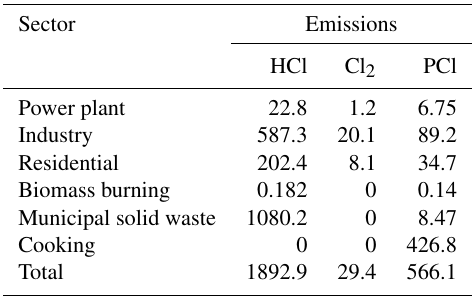
Table 1. The sectoral emissions of HCl, Cl 2 and PCl in Beijing in 2017 (unit: Mgyr − 1